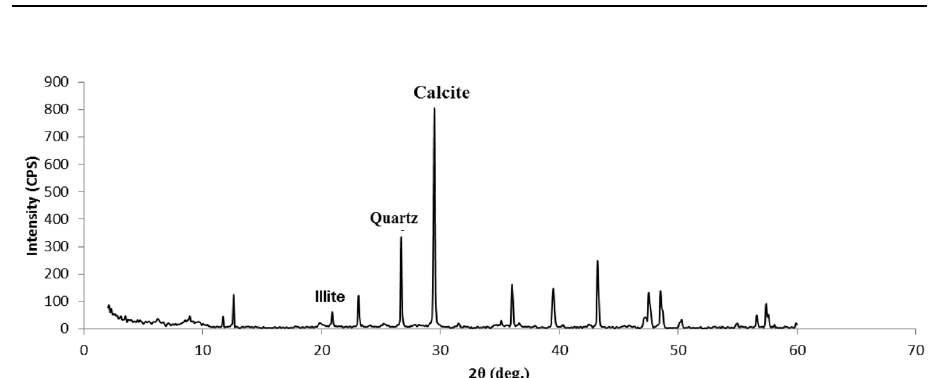
Table 2 Chemical composition of the soil (XRF results)